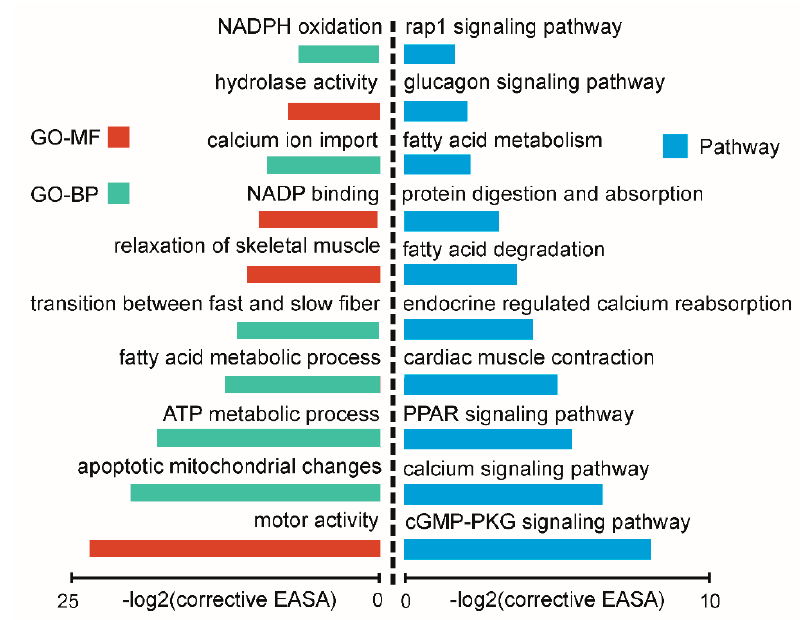
Figure 7. The top ten GO terms and KEGG annotations for host genes of differentially expressed circRNAs. The EASE score, which indicated the significance of comparisons, was calculated by Benjamin-corrected modified Fisher’s exact test.